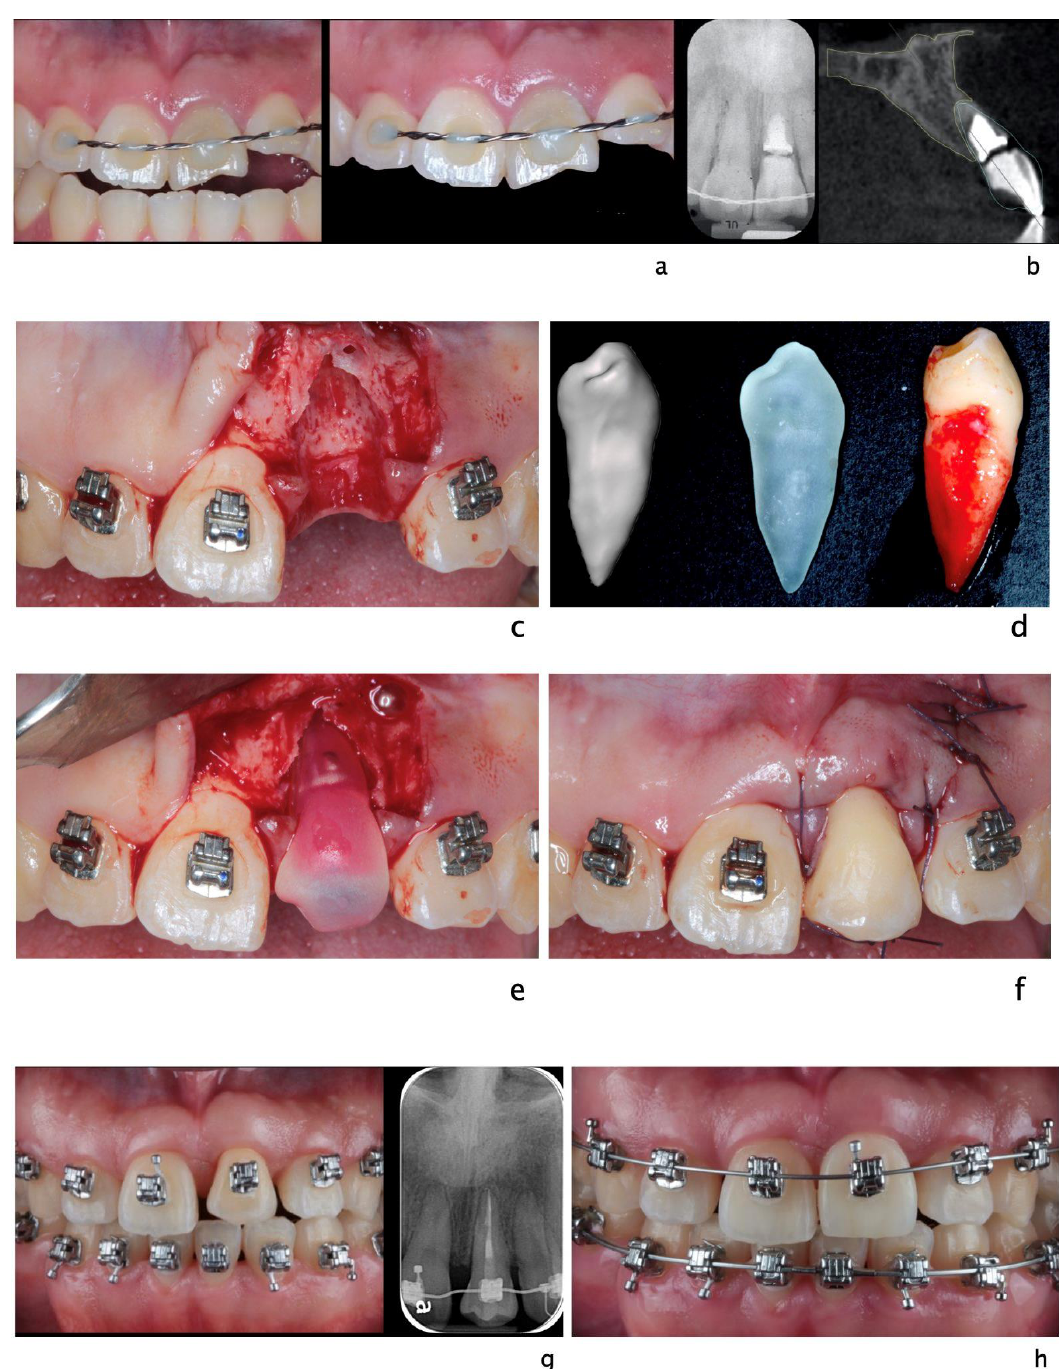
Figure 3. A 20-year-old Asian male had #8 diagnosed with a root fractured due to sport related trauma ( a ). The tooth was endodontically treated, followed by healing with interposition of connective tissue ( b ). After healing was completed, a second sport injury involved the same tooth. The tooth mobility increased, and a periodontal lesion was diagnosed by elevated probing depth. The tooth was stabilized with orthodontic wire and patient was referred to periodontist for evaluation. Combined with malocclusion and anterior open-bite, the treatment plan was made as full-month orthodontics and auto-transplantation of #28. Tooth #8 and 28 were extracted ( c , d ) and a premolar replica was printed ( d ). After socket adjustment with the replica ( e ), tooth #28 was stabilized in place with sutures ( f ). After periodontal stabilization and verification of periodontal healing ( g ), the final restoration was delivered ( h ).